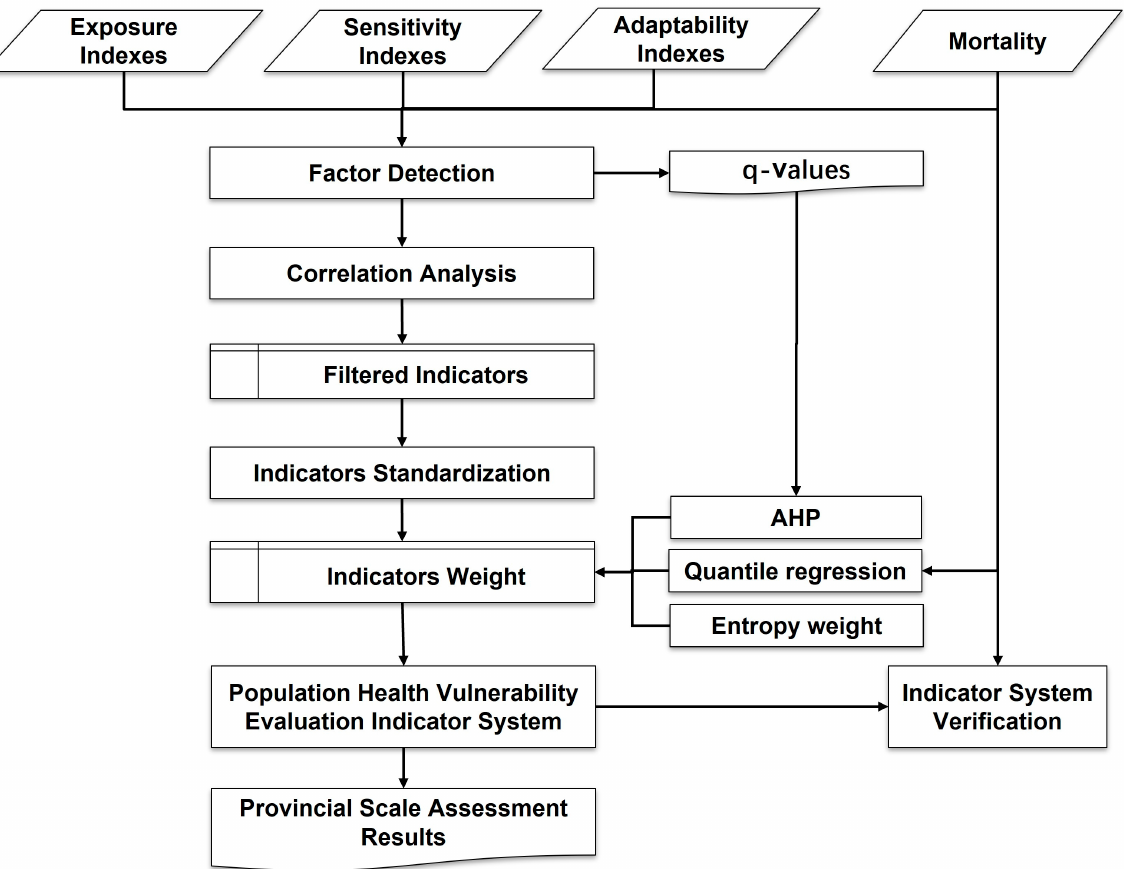
Figure 2. Flow chart of population health vulnerability assessment.